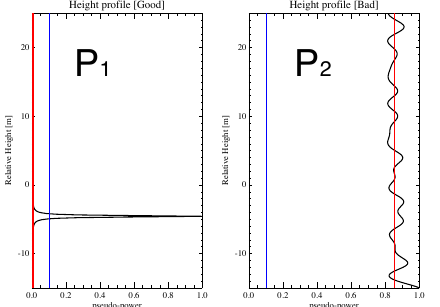
Figure 7: Normalized pseudo-spectrum for p 1 and p 2 . The red line indicates the median value for each spectrum and the blue line represents the threshold.